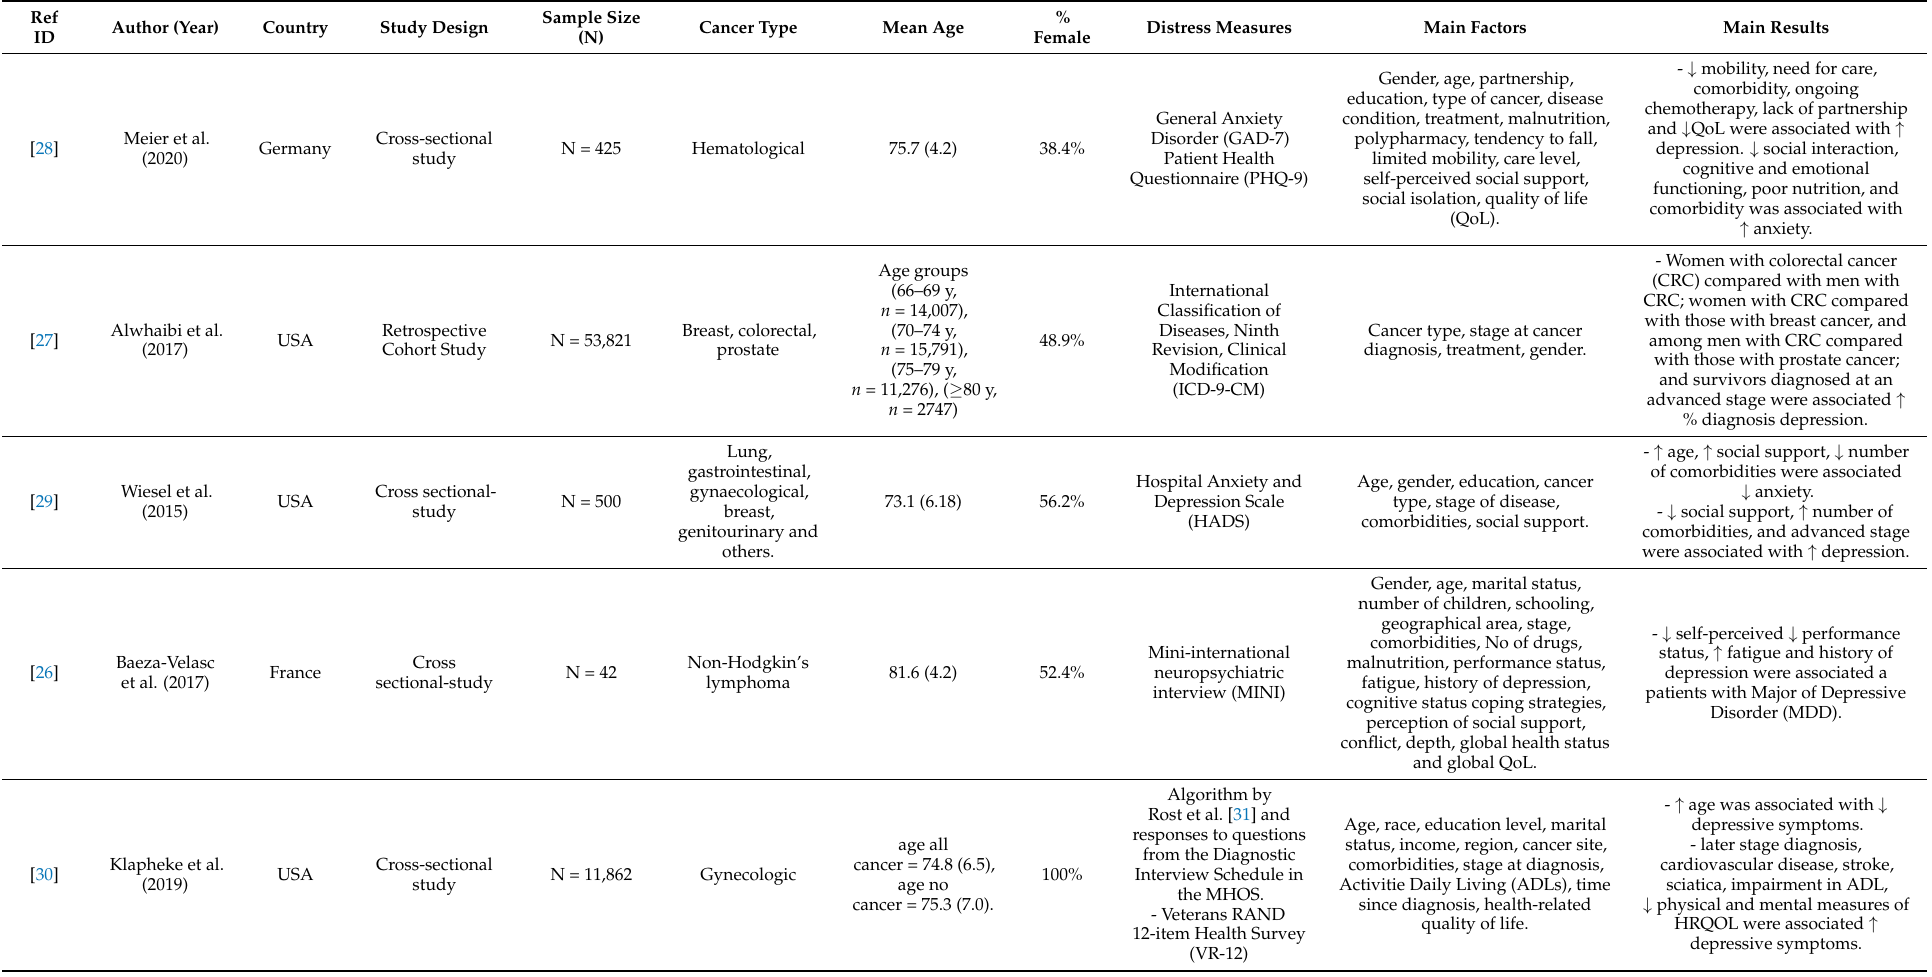
Table 1. Descriptive characteristics and results of the included